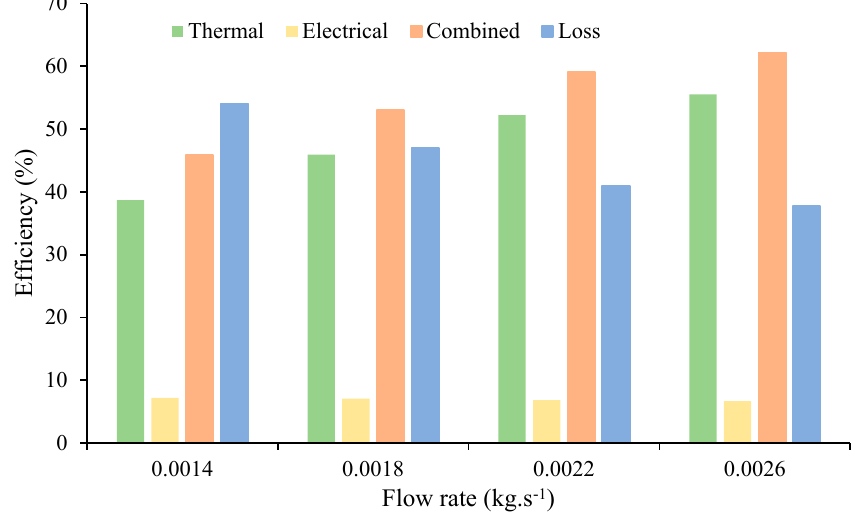
Figure 7. System efficiency variation at different mass flow rates.